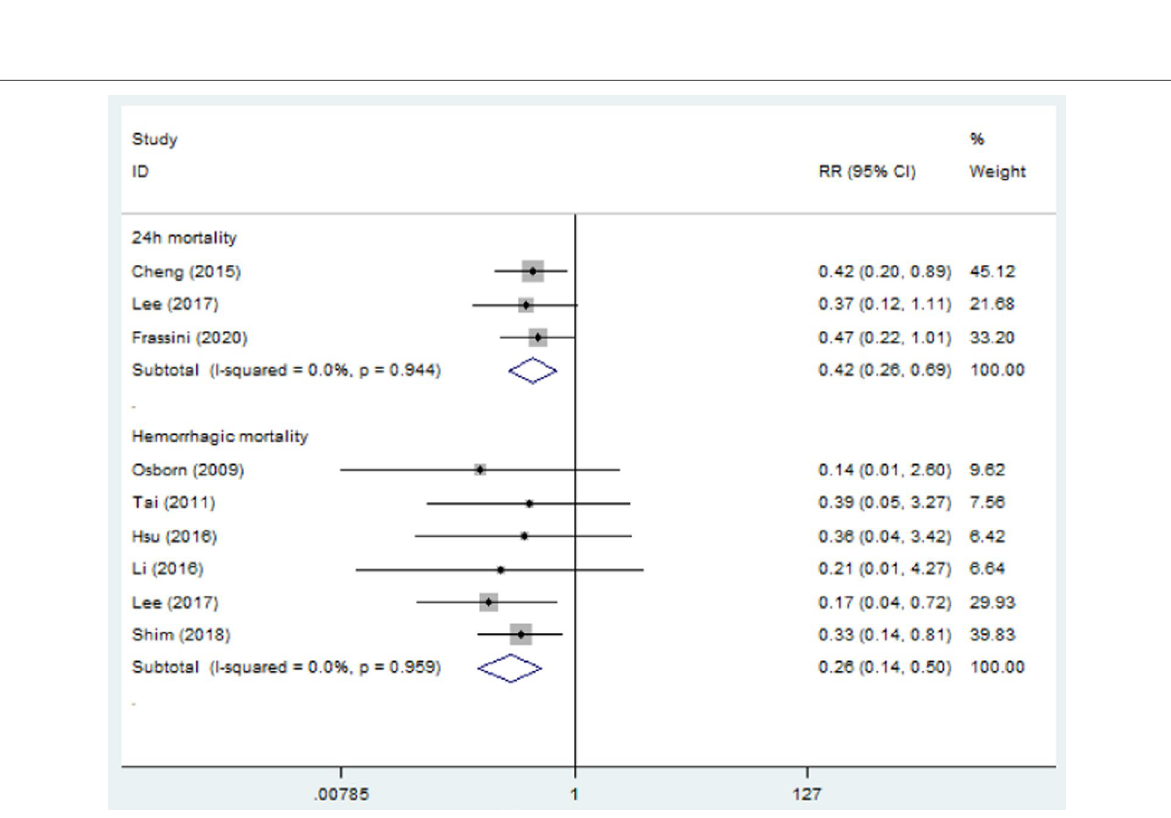
Fig. 5 Forest plot involving a comparison of early mortality. RR relative risk, CI confidence